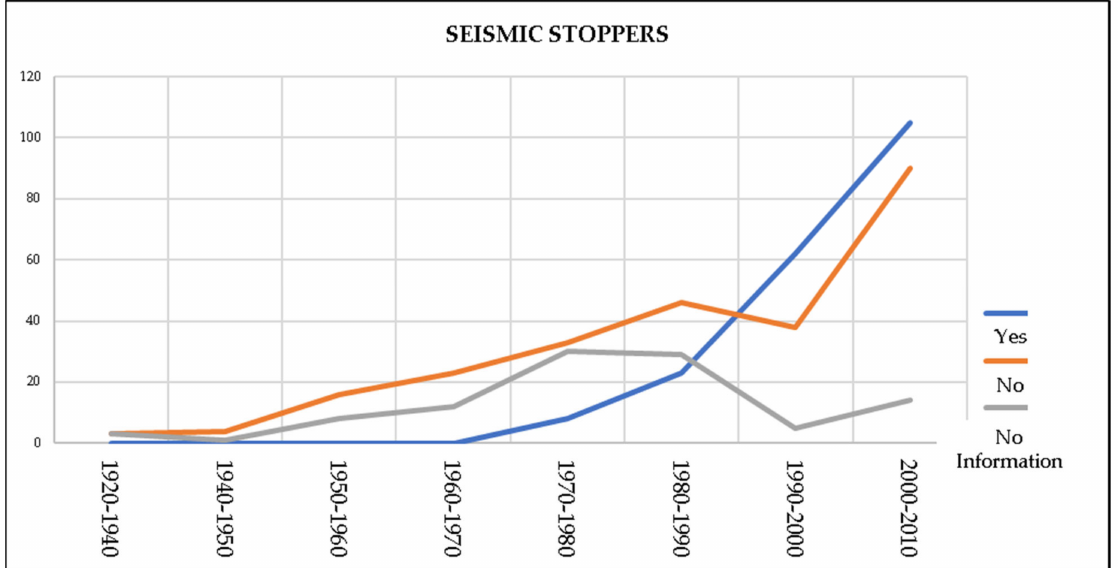
Figure 10. Historical evolution of the implementation of seismic